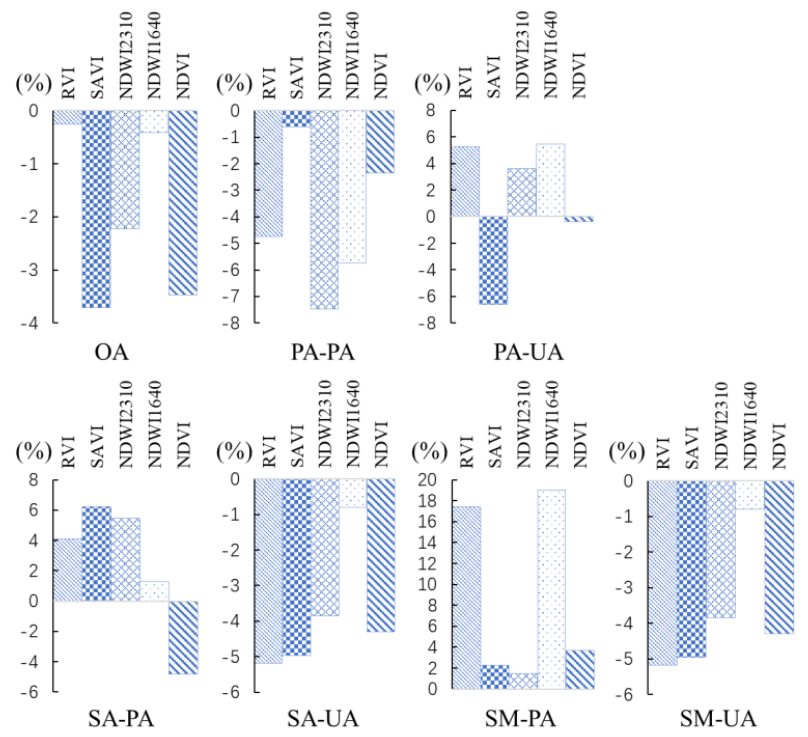
Figure 8. The percentage changes in classifications accuracy when each kind of VI (NDVI, ratio vegetation index (RVI), soil normalized vegetation index (SAVI), 1640 nm shortwave infrared vegetation index (NDWI1640), and 2310 nm shortwave infrared vegetation index (NDWI2310)) is removed from variable combinations.